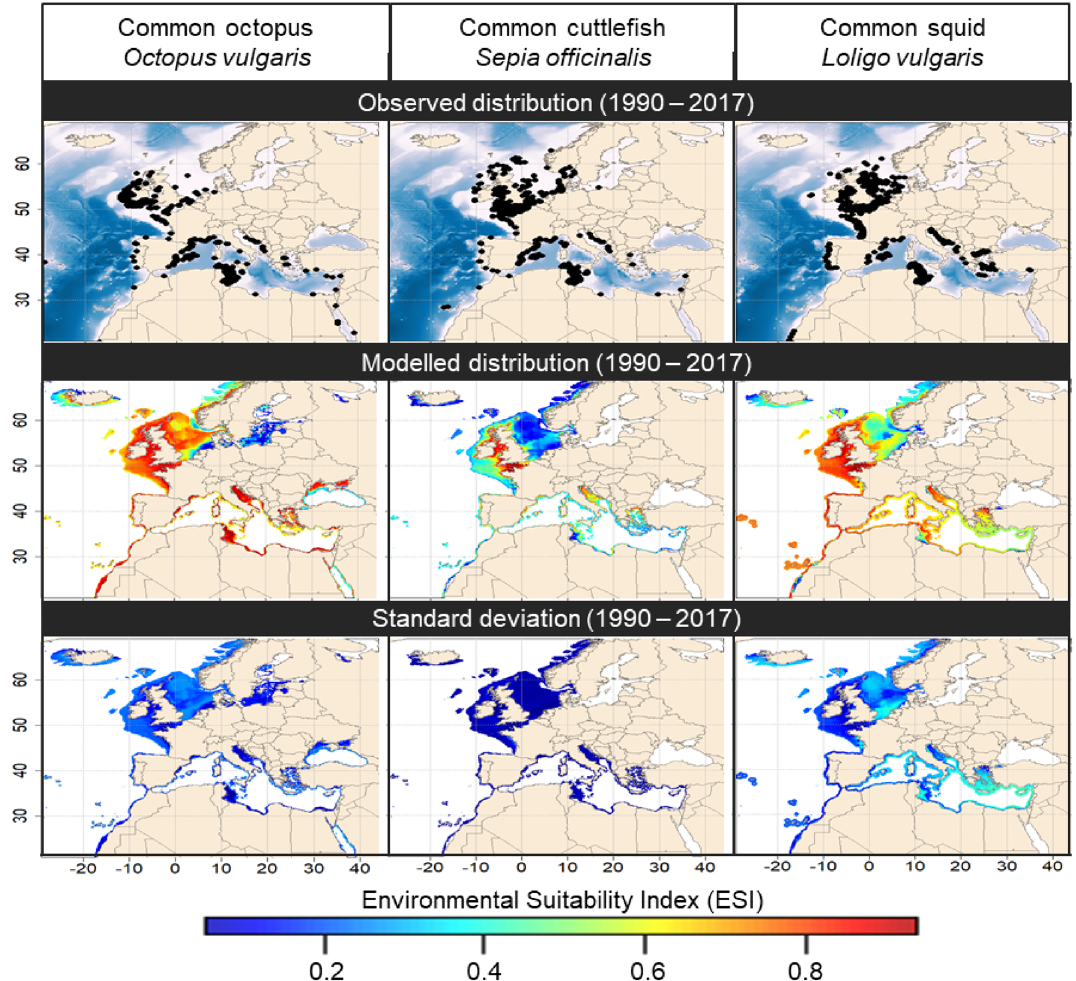
Figure 1. Top panels: observed contemporary (1990–2017) distribution in Europe of the three cephalopods species ( O. vulgaris, S. officinalis, L. vulgaris ). Each black dot represents an occurrence record. Middle panels: modelled contemporary (1990–2017) distribution represented in term of environmental suitability index ranging from 0 (low suitability) to 1 (maximum suitability). Bottom panels: corresponding standard deviation based on all SDM and cross-validation runs, of three studied cephalopod species in European waters. Note that a narrow distance to coast threshold has been added for common octopus and common cuttlefish for visual purposes only because of the coarse (i.e. 0.1°) coastal resolution. Maps were generated by A.S. using the R v3.4.4 software (R Core Team, 2018; https ://www.R-proje ct.org/), specifically the “raster” and “maptools” package. World borders were retrieved from http://thema ticma pping